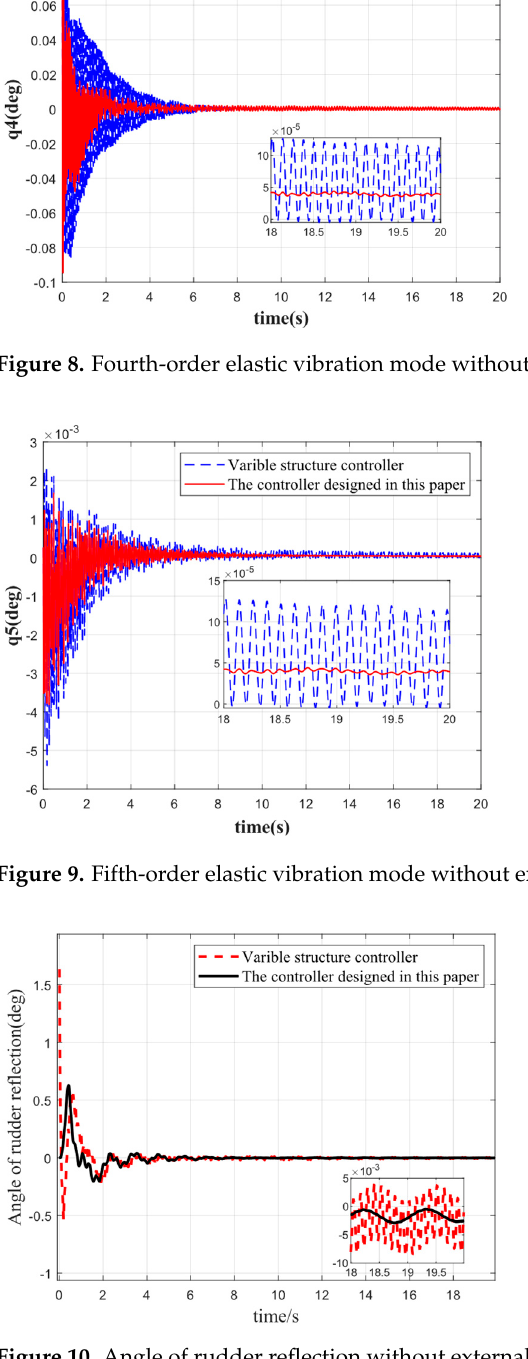
Figure 10. Angle of rudder reflection without external interference.